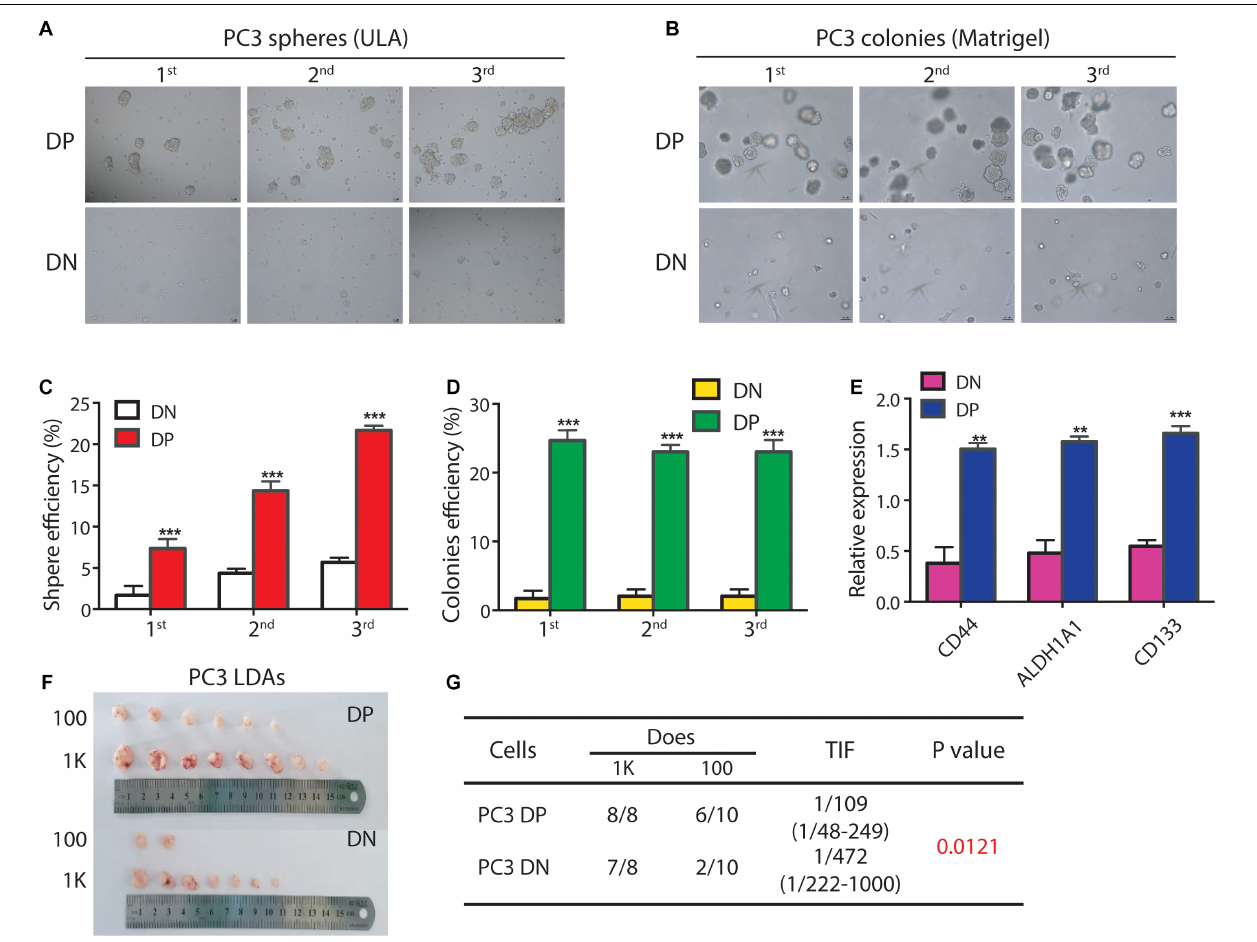
FIGURE 1 | The PC3 ALDH hi CD44 + PCa cells enrich for PCSCs. (A,B) The PC3 ALDH hi CD44 + (DP) PCa cells have higher clonogenicity than isogenic ALDH lo CD44 − (DN) PCa cells. (A) For sphere assays, PC3 DP and corresponding DN cells were freshly purified by FACS and seeded in ultra-low attachment (ULA) plates (1,000 cells/well). Spheres were counted and photographed 12 days later. The 1 ◦ spheres were harvested and passaged for 2 ◦ spheres (1,000 cells/well) in ULA plates, which were then harvested for 3 ◦ spheres. (B) . For colony formation assays, PC3 DP and DN cells were mixed with Matrigel (1,000 cells/well) in 24-well cell culture plates. The 1 ◦ colonies were harvested and passaged for 2 ◦ colony-formation assays (1,000 cells/well), which were then harvested for 3 ◦ clonogenic assays. Data is presented from three separate experiments. Scale bars, 100 µ m. (C) Spheres were counted for sphere formation assays (A) and the sphere efficiency was presented for three generations. *** P < 0.001. (D) Colonies were enumerated for colony-formation assays (B) and the colony efficiency was shown for 3 generations. *** P < 0.001. (E) Expression of mRNA levels for CD44 , ALDH1A1 , and CD133 is much higher in PC3 DP cells (vs. DN cells). GAPDH was served as a loading control. Data was collected from there independent experiments. ** P < 0.01, *** P < 0.001. (F,G) PC3 DP cells are more tumorigenic than PC3 DN cells in male NOD/SCID mice. PC3 DP and DN cells were freshly sorted via FACS, and injected subcutaneously in male NOD/SCID mice for limiting dilution assays